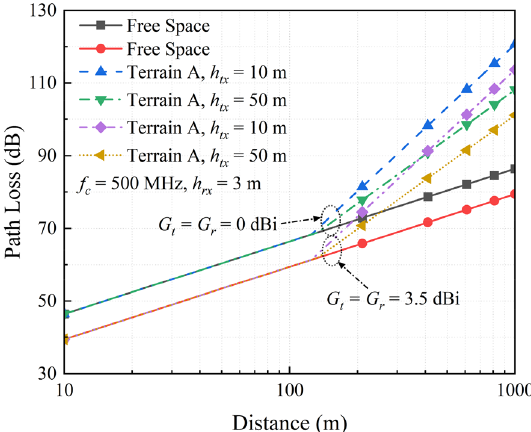
Figure 2. Simulated path loss versus communication distance in the mountainous and dense forest